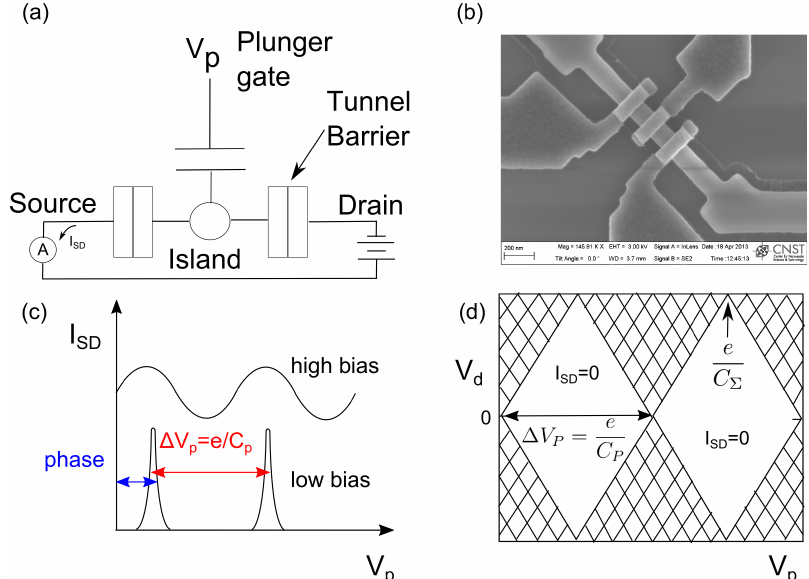
Figure 1. ( a ) electrical diagram representation of a single electron device (SED); ( b ) scanning electron micrograph (SEM) of a silicon SED. The micrograph shows an etched and oxidized silicon nanowire with three wraparound finger gates made of doped polySi used to create barriers and form dots. An upper gate (not shown) provides the carriers and stretches from source to drain of the device; ( c ) coulomb blockade oscillations as a function of the plunger gate voltage depicted at high and low e ; and ( d ) schematic of bias, V D . The phase is indicated and leads to our definition of Q 0 ≡ phase ∆ V P Coulomb diamonds (current measured as a function of plunger gate voltage and drain bias). The hatched areas exhibit non-zero source-drain current while the central diamonds show no current because the electrostatics fixes the number of electrons on the dot. The height of the diamonds gives the charging energy and the period in V p gives the capacitance between gate P and the